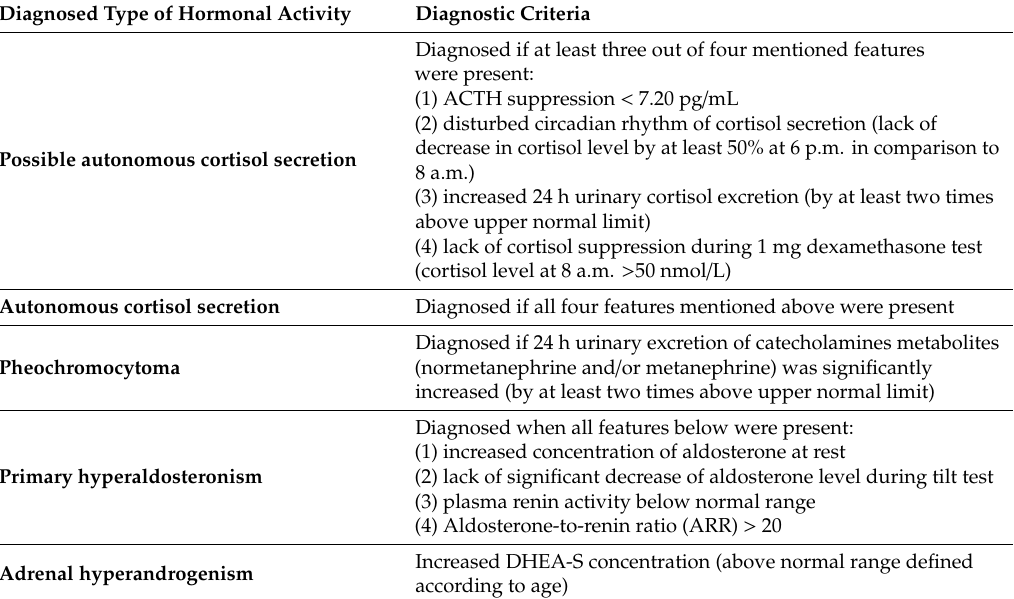
Table 1. The established diagnostic criteria of hormonal activity of adrenal